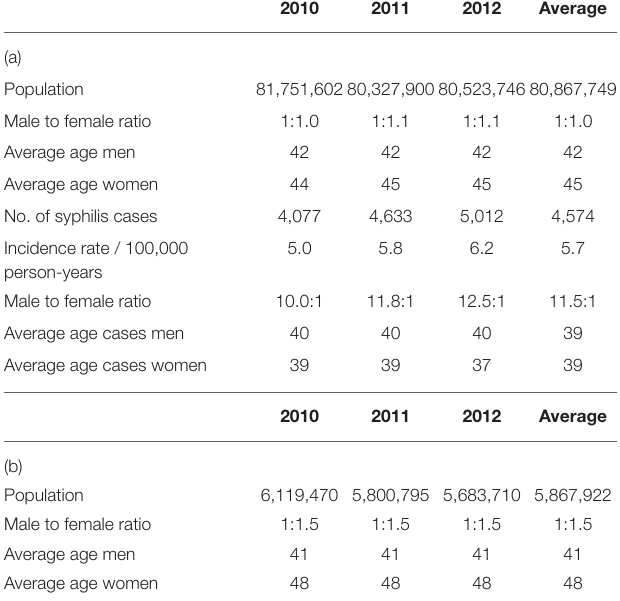
TABLE 1 | Basic characteristics of the datasets used for this model analysis for 2010 to 2012.